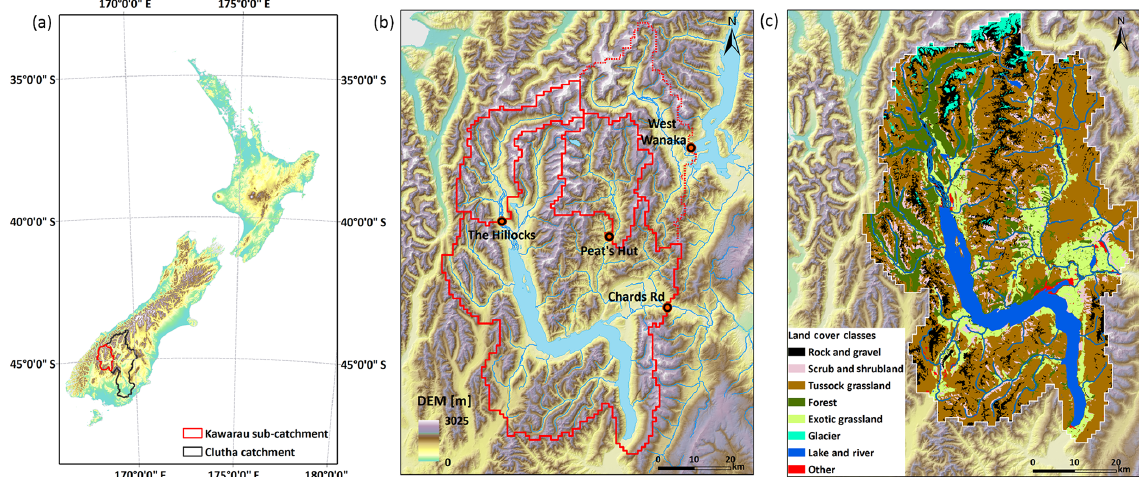
Figure 1. Maps showing (a) New Zealand with the Clutha catchment located in the lower South Island, (b) the sub-catchments of the gauges recording streamflow used in this study (note that the West Wanaka sub-catchment is outside the Kawarau sub-catchment) and (c) a land cover classification of the Kawarau sub-catchment based on New Zealand’s Land Cover Database (LCDB v3.0) that was published by Landcare Research in